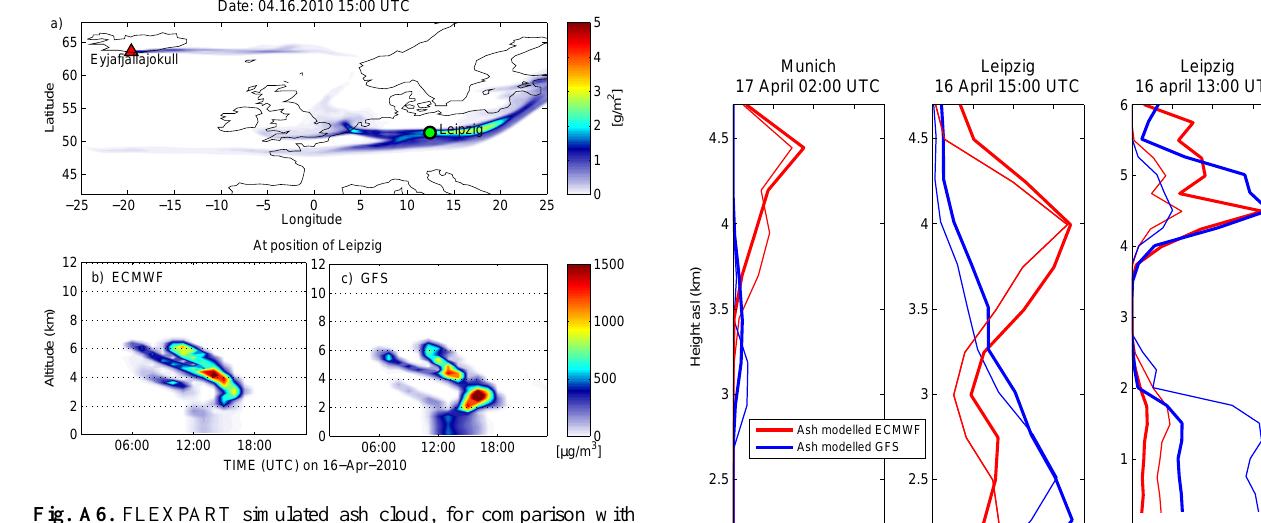
Fig. A6. FLEXPART simulated ash cloud, for comparison with published lidar observations. (a) FLEXPART a posteriori simula- tion (running on ECMWF data) of total ash column load. (b) and (c) simulated vertical distribution of ash, using ECMWF and GFS data respectively, over Leipzig (51.4 ◦ N, 12.4 ◦ E) on 16 April, to be compared with lidar observations (Fig. 1 in Ansmann et al., 2010).